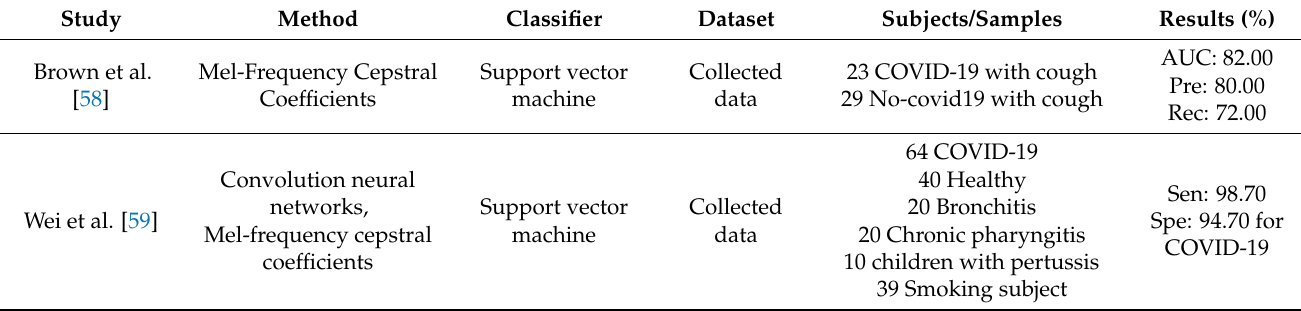
Figure 8. Classification accuracy (%) obtained for various classifiers using 1024 generated features. The performance parameters (%) obtained for automated Covid-19 detection using cough sound signals is depicted in Table 2.